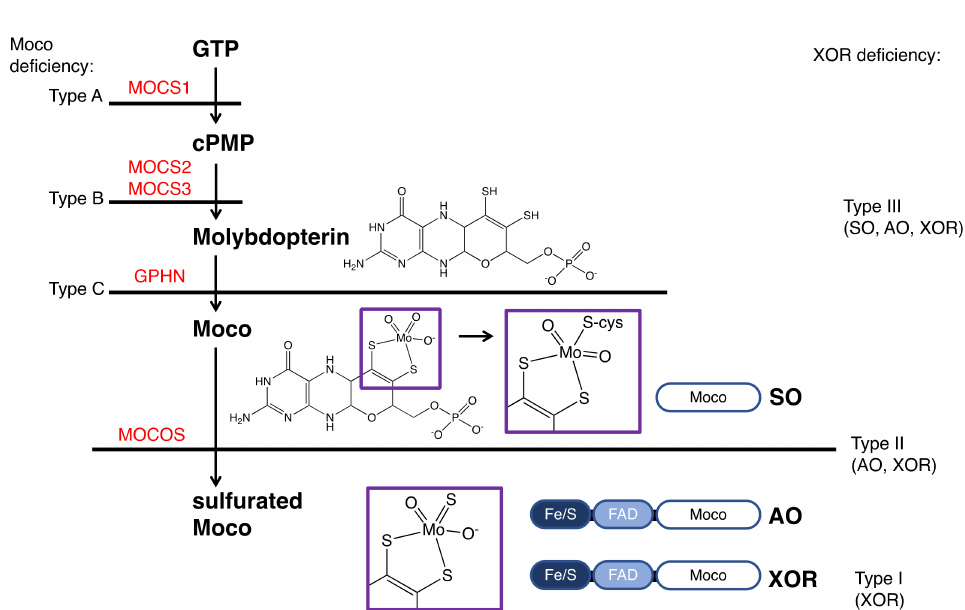
Figure 6. XOR deficiency and the biosynthetic pathway of Moco. The classifications of the types of Moco and XOR deficiency is shown on the left and right, respectively. Enzymes involved in the biosynthesis of Moco are shown in red. Mutations causing Moco deficiency have been identified in the genes MOCS1 (type A), MOCS2 or MOCS3 (type B), and rarely in GPHN (type C). The domain structures of SO, AO, and XOR and the final maturity of Moco are shown. The atoms coordinating to Mo are shown in the purple